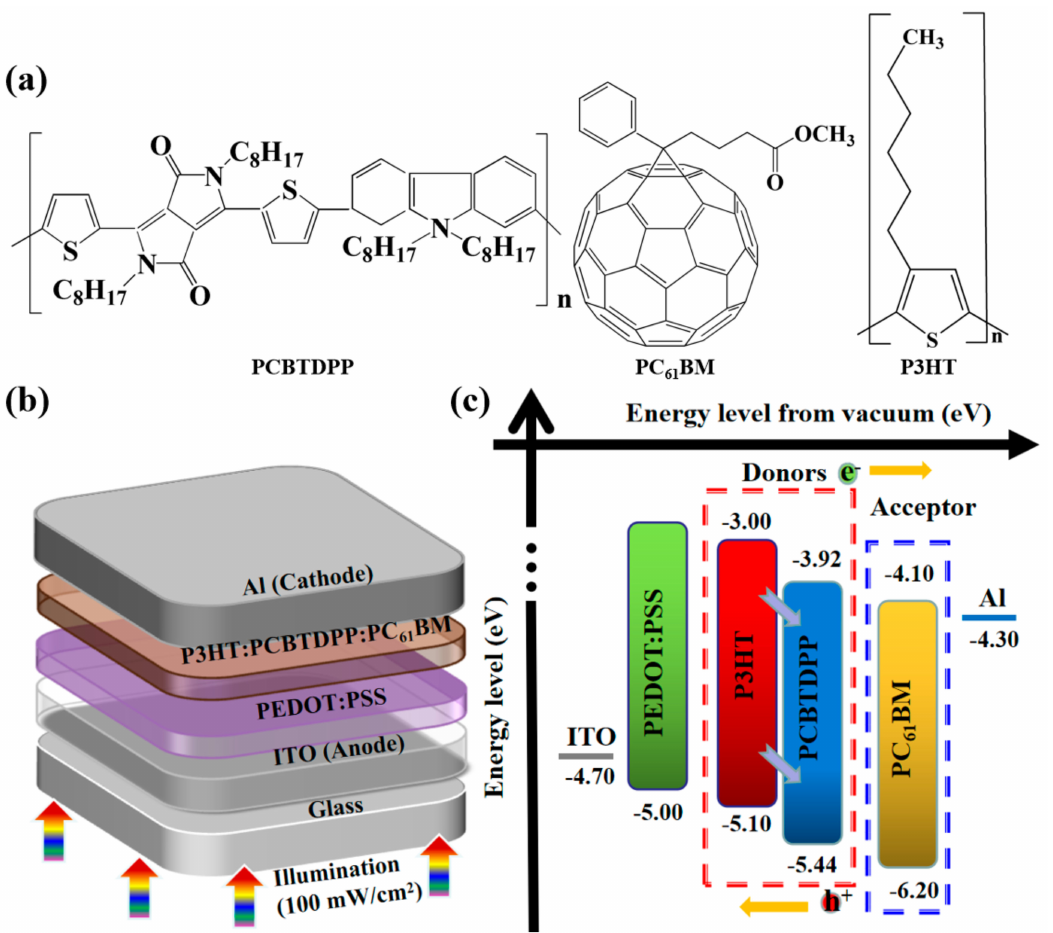
Figure 1. ( a ) The chemical structures of poly[ N -90-heptadecanyl-2,7carbazole-alt-3,6-bis(thiophen-5-yl)- 2,5-dioctyl-2,5-dihydropyrrolo[3,4]pyrrole-1,4-dione] (PCBTDPP), poly(3-hexylthiophene):[6,6] (P3HT), and phenyl-C61-butyric acid methyl ester (PC61BM), ( b ) device geometry, and ( c ) energy band levels of the studied components. ITO = indium tin oxide; poly (3,4-ethylene dioxythiophene): poly (styrene sulfonate) =